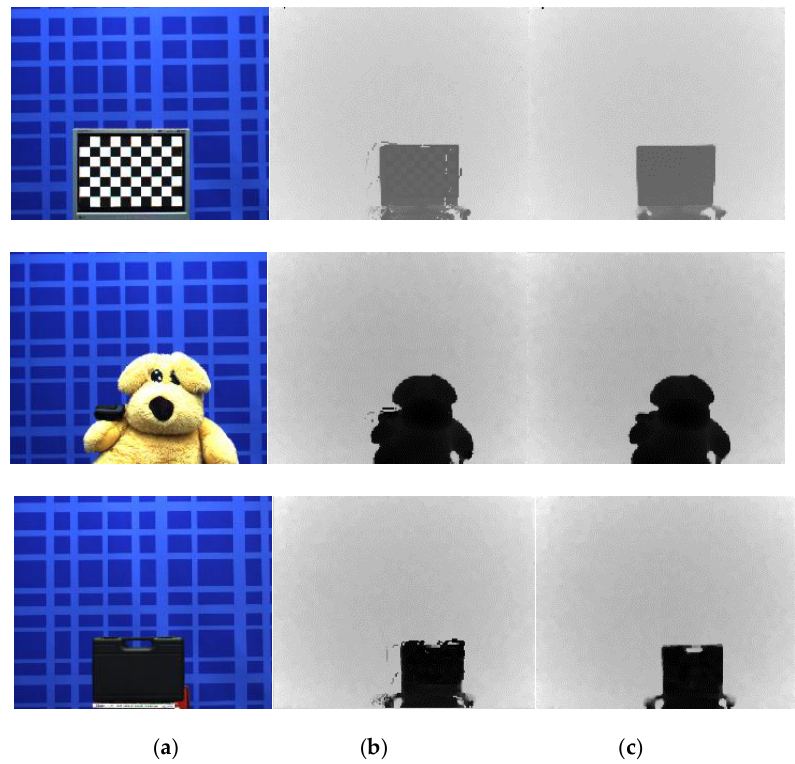
Figure 12. Results of error detection.